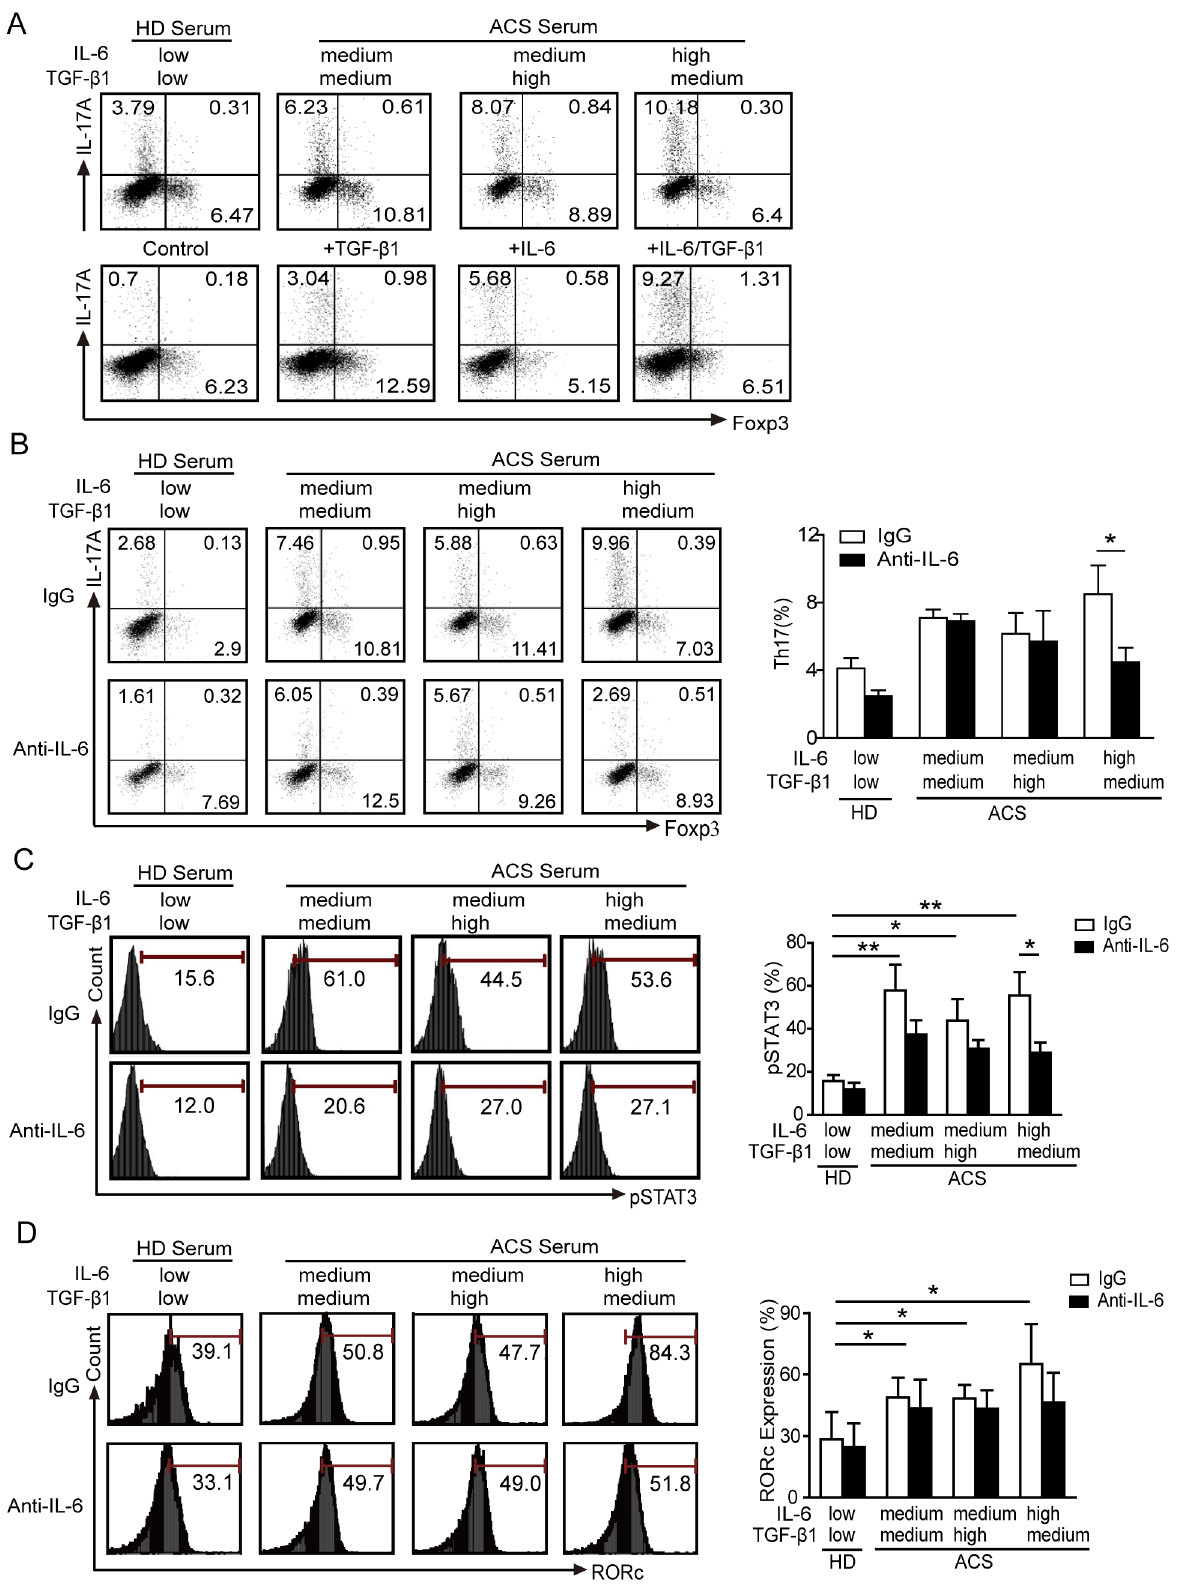
Figure 4. IL-6 neutralization prevents Th17 cell differentiation from naı¨ve CD4 + T cells. Representative FCM results. (A) Frequencies of Th17/Treg cells detected in PBMCs from HD after stimulation with ACS patient sera (upper panel) and with the indicated cytokines (lower panel). Cells cultured in vitro with plate bound anti-CD3 and soluble anti-CD28. Data are representative of 5 independent experiments. (B-D) Naı ¨ ve T cells from